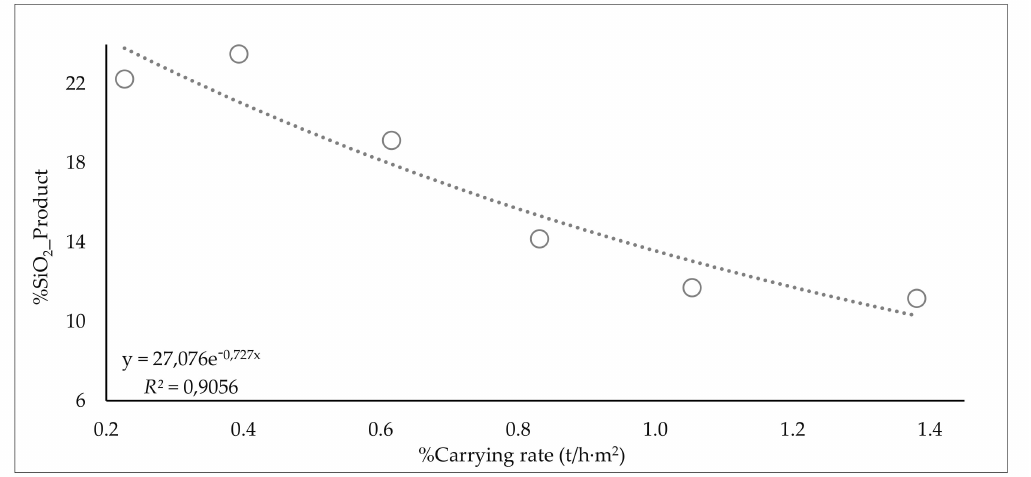
Figure 23. Trend between the carrying rate and SiO 2 content in the product concerning the pilot test